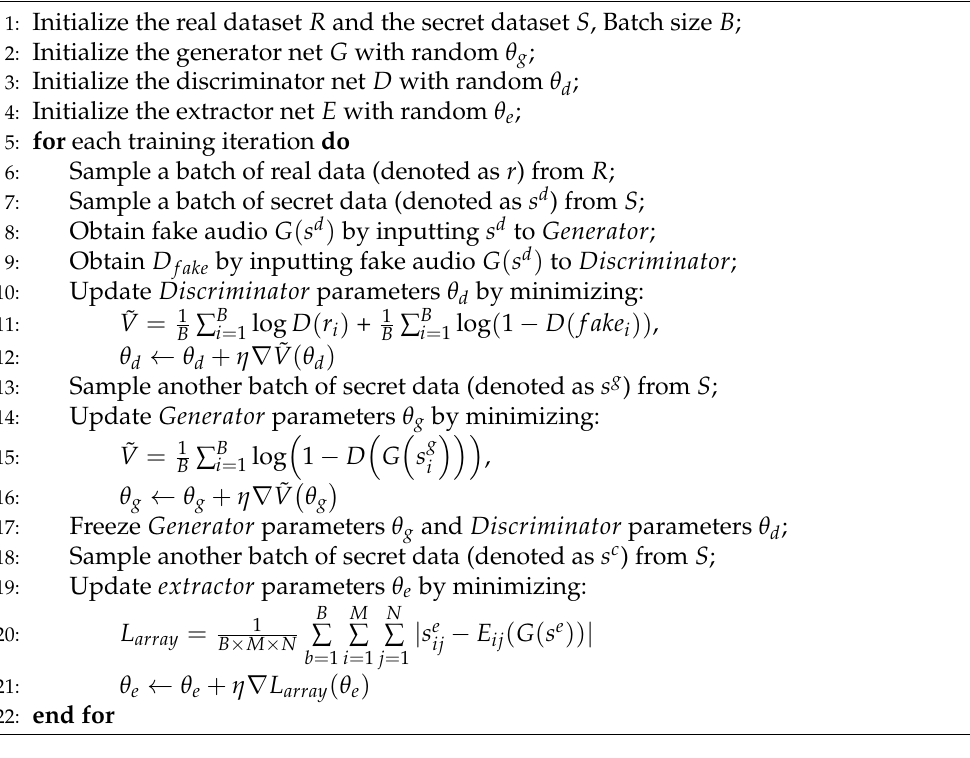
Algorithm 1 The training process of the proposed model.